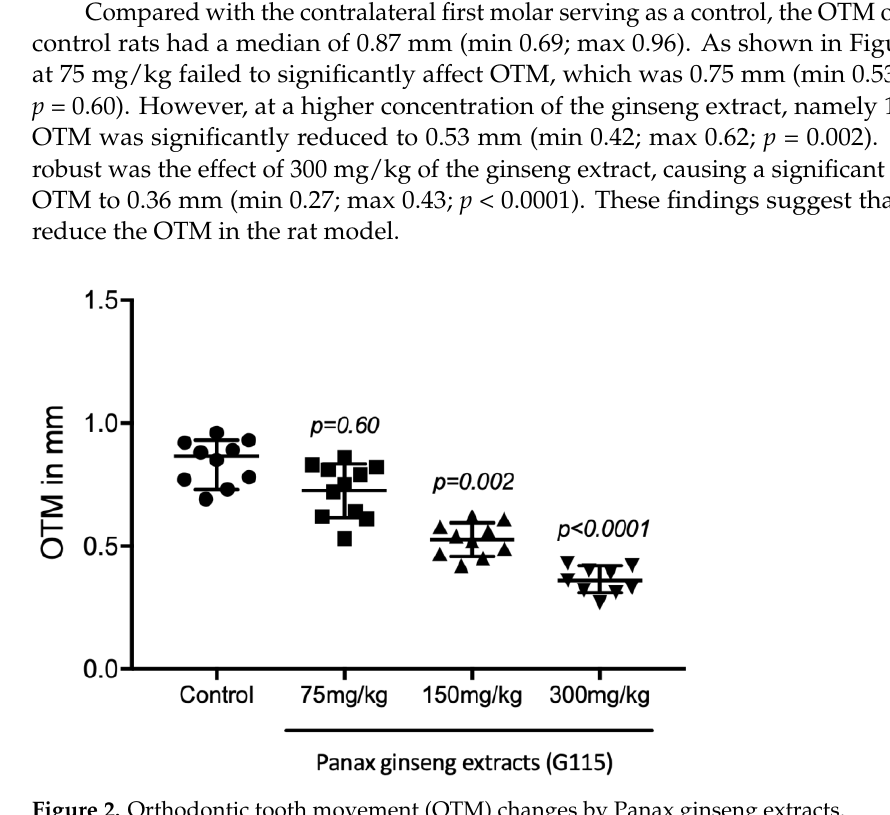
Figure 2. Orthodontic tooth movement (OTM) changes by Panax ginseng extracts . The orthodontic force was applied to move the right, upper, first molar towards the upper incisors. Three weeks following appliance insertion, OTM was measured